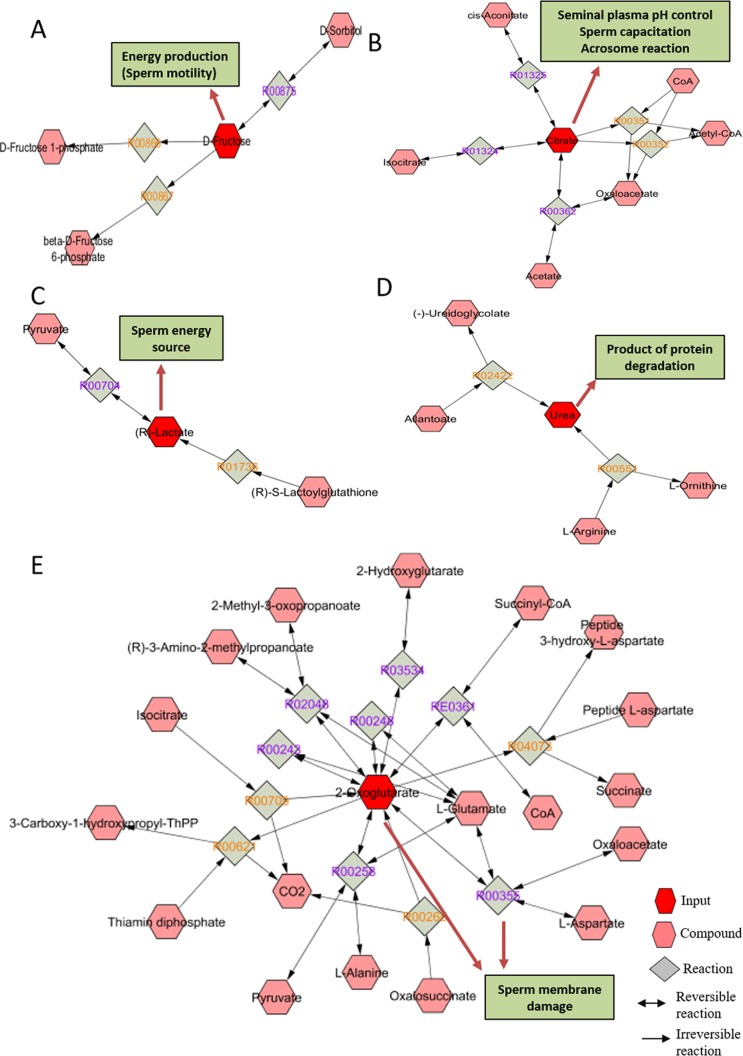
Metabolic networks associated with metabolites identified in bull seminal plasma.(A) fructose, (B) citric acid, (C) lactic acid, (D) urea, (E) 2-oxoglutaric acid. Networks were generated using the Metscape plug-in for Cytoscape. Metabolites are shown in red hexagons. Compounds are represented as pink hexagons, reversible reactions as gray squares with purple text and non-reversible reactions as gray squares with orange text.